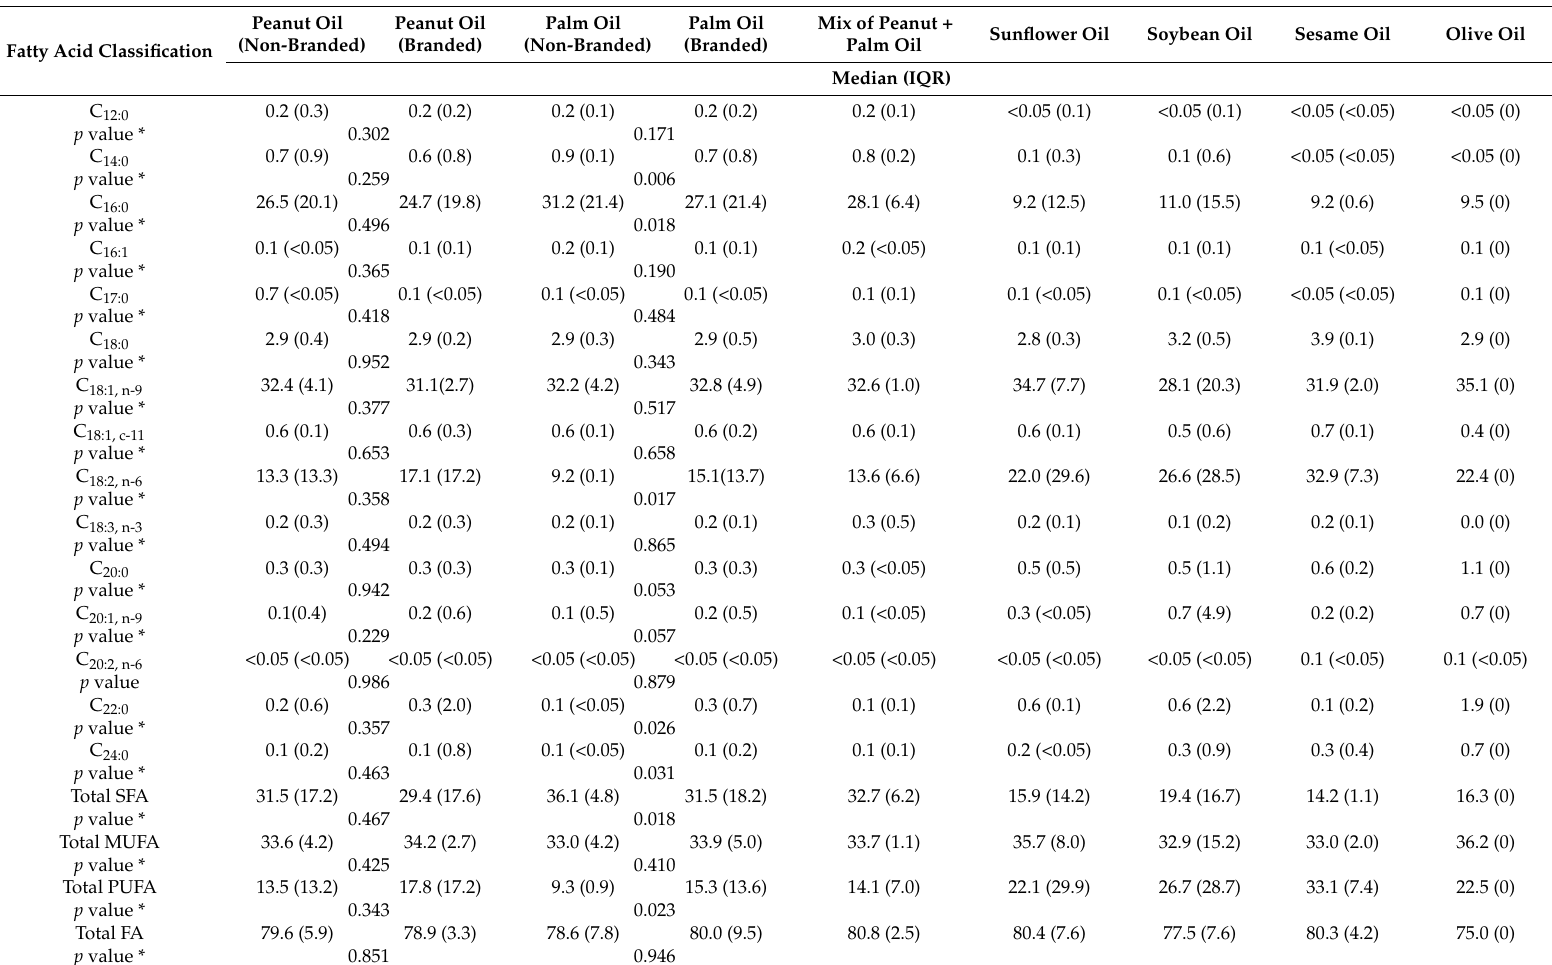
Table 2. Median values and interquartile range (IQR) of the fatty acid composition of vegetable oils (in grams of fatty acids/100 g of oil) from the Yangon region, 2016.